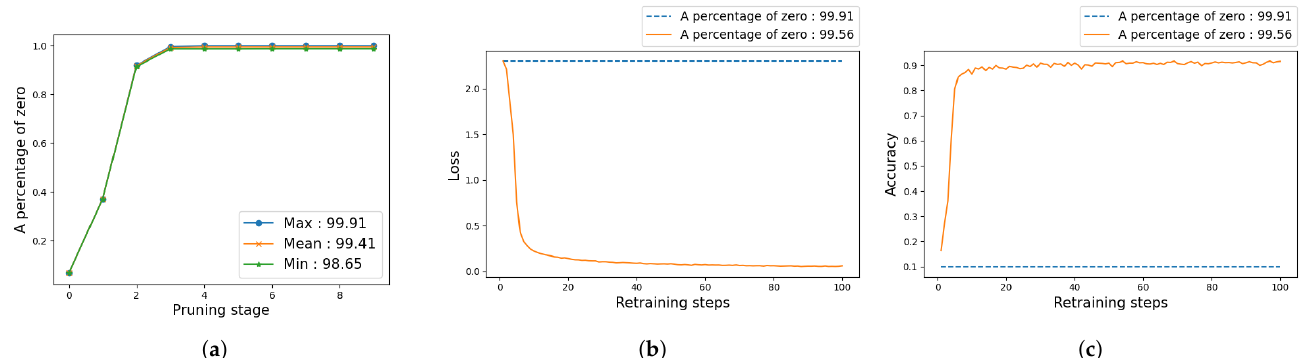
Figure 6. The results by compressing the network as much as possible: ( a ) the minimum, maximum, and mean percentage of zeros (related with compression rate), ( b ) corresponding retraining loss, and ( c ) accuracy for the maximum percentage and the non-maximum percentage, respectively.